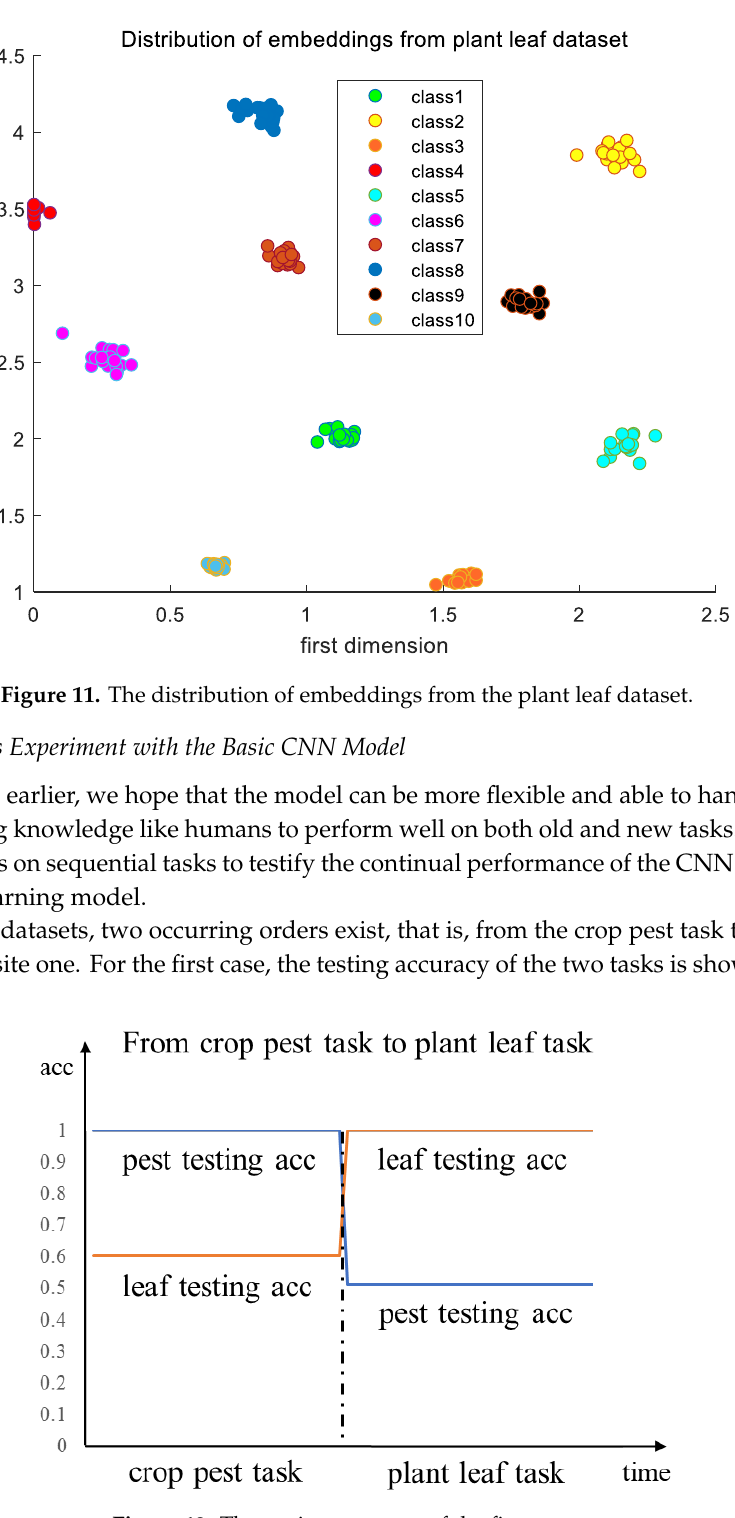
Figure 12. The testing accuracy of the first case. At the first stage, the model has a good performance on the crop pest dataset, which was verified in Section 3.1. However, it has a very bad performance on the other dataset. The reason is that the other dataset is an unknown task and has never been seen before; this result is understandable and acceptable. At the second stage, the model begins to learn the plant leaf task. Note that the model also learnt the crop pest task in the past. After the training period, the testing accuracy on the plant leaf task increases to 100% while that of the crop pest dataset decreases to nearly 50%, which is almost a blind guess. So, the extent of catastrophic forgetting for the crop pest task is nearly 50%. The new distribution of output embeddings from the old crop pest task is shown in Figure 13, which indicates that the basic metric learning model has lost the ability to distinguish the similarity between input paired images. The extracted features (embedding) of samples from different categories are mixed, and cannot be separated. This is an undesired forgetting problem!